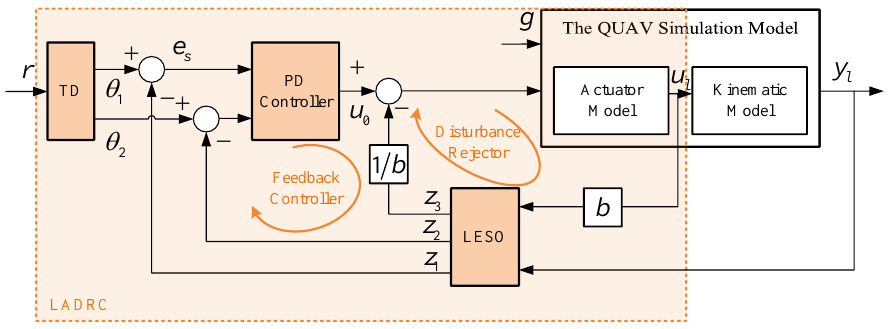
Figure 2. Layout of the Quadrotor LADRC